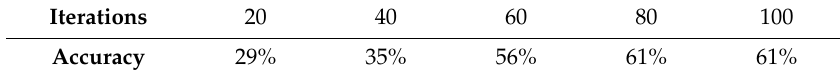
Table 5. Average classification accuracy and number of iterations in the training process.